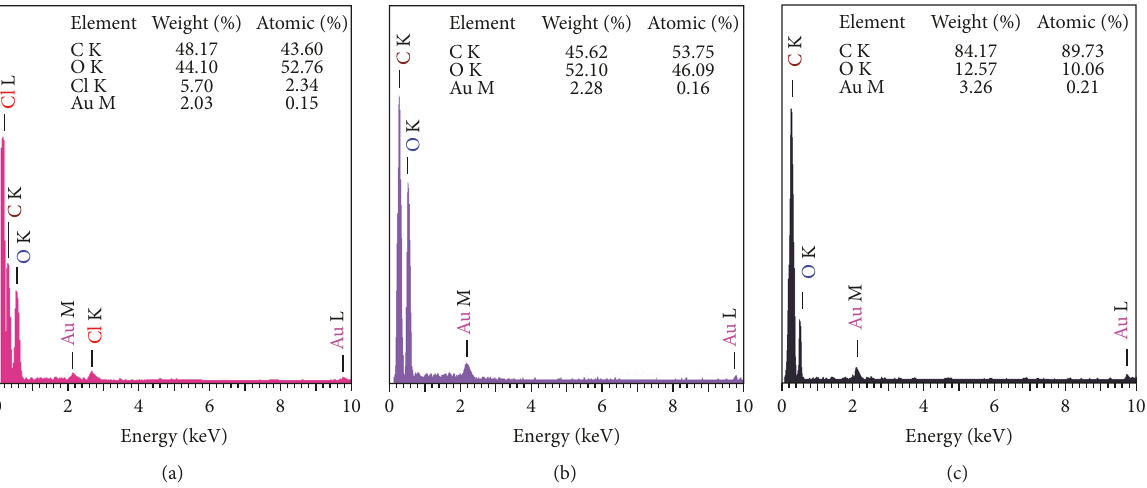
Figure 9: EDX spectra of AuNPs/dextran powders: spray drying (a), coagulation (b), and centrifugation (c).